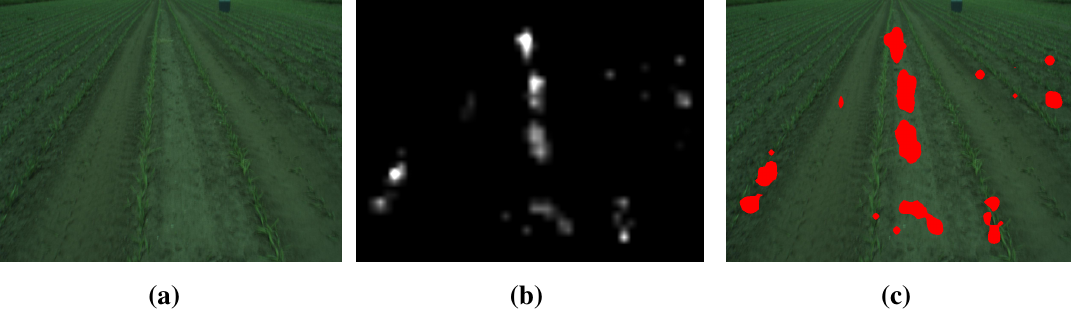
Figure 6. Example of visual saliency in captured data. ( a ) Input RGB color image; ( b ) saliency map; ( c ) red regions are not selected for the background model.